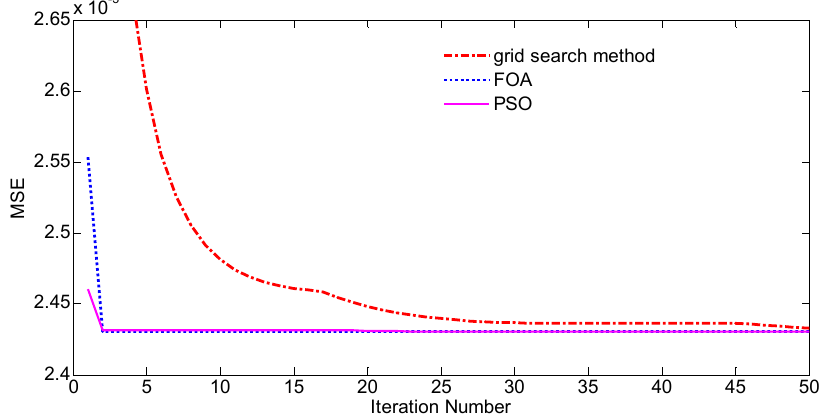
Figure 7. Convergence histories of least squares support vector machine (LS-SVM) parameters using different optimization algorithms.